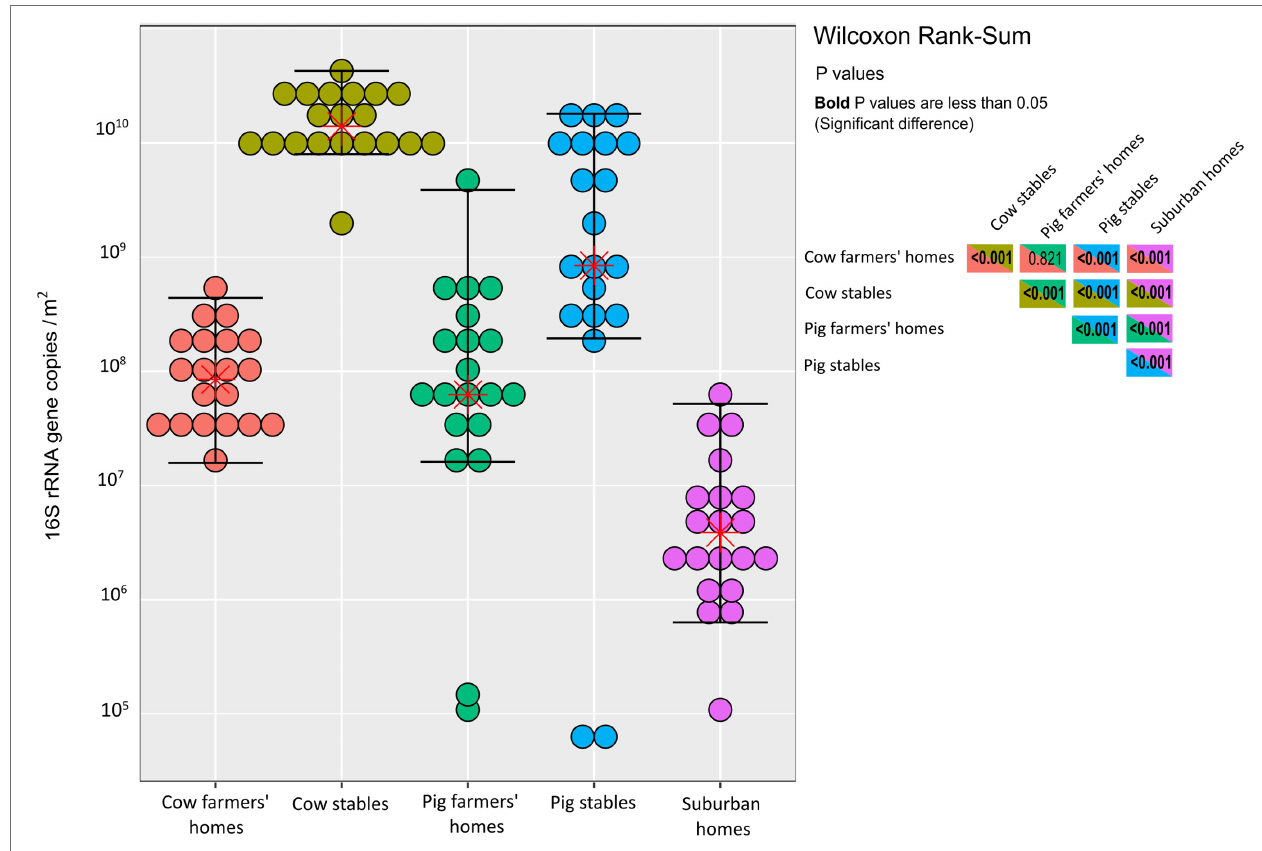
FIGURE 1 | Dot-plot of quantitative PCR measurements of the 16S rRNA genes in each indoor environment. Units are 16S rRNA gene copies per m 2 of EDC (following 14 days of exposure). The horizontal lines are whiskers of 1.5 IQR (interquartile range) of the upper quartile and lower quartile, while the stars represent the mean. The statistical significance of the differences depicted in this figure is demonstrated in the inset box, which contains Wilcoxon rank sum test results for various comparisons between the indoor environment types. p values in bold indicate